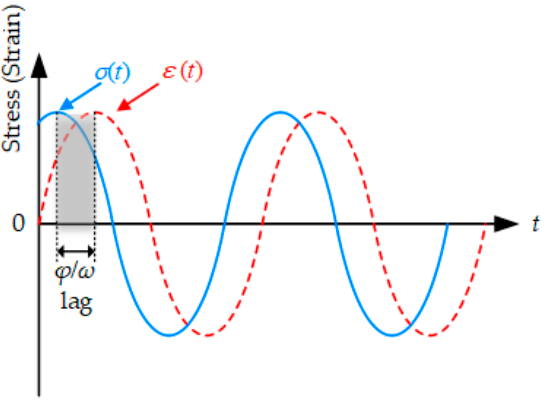
Figure 5. Curves of stress and strain in complex modulus test.